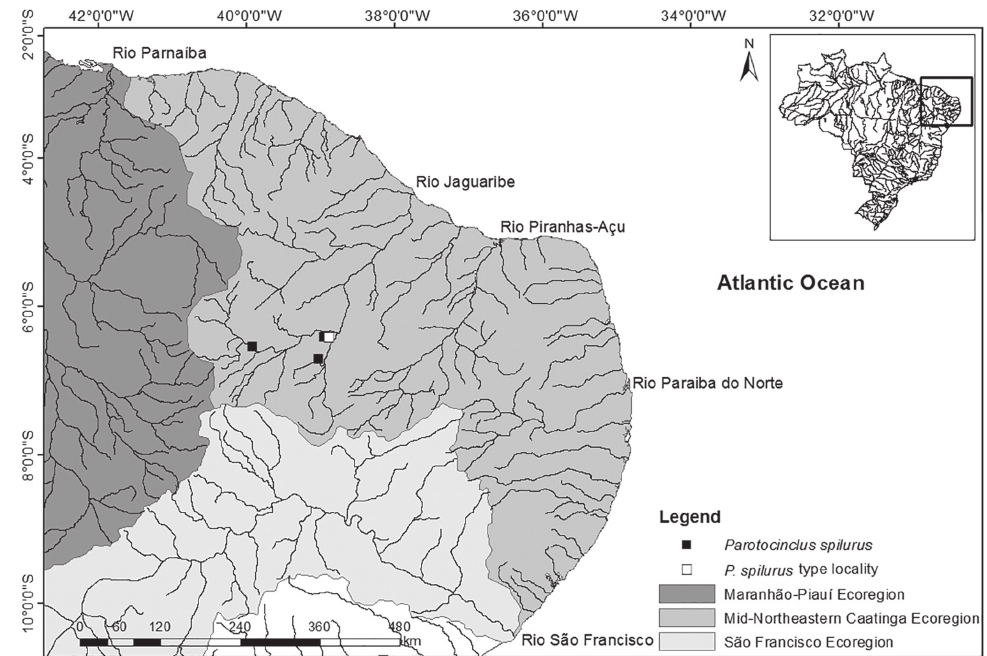
Fig. 8. Geographic distribution of Parotoncinclus spilurus in upper Jaguaribe, Ceará State, northeastern Brazil. Open symbol represents type locality Icó Municipality, rio Salgado, rio Jaguaribe